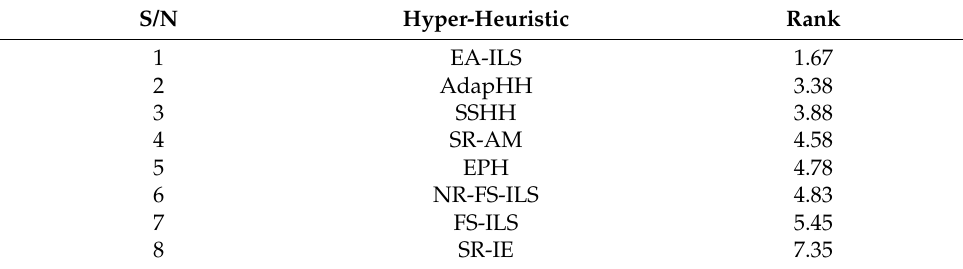
Table 9. Ranking of the Hyper-Heuristics Using the Friedman Test.